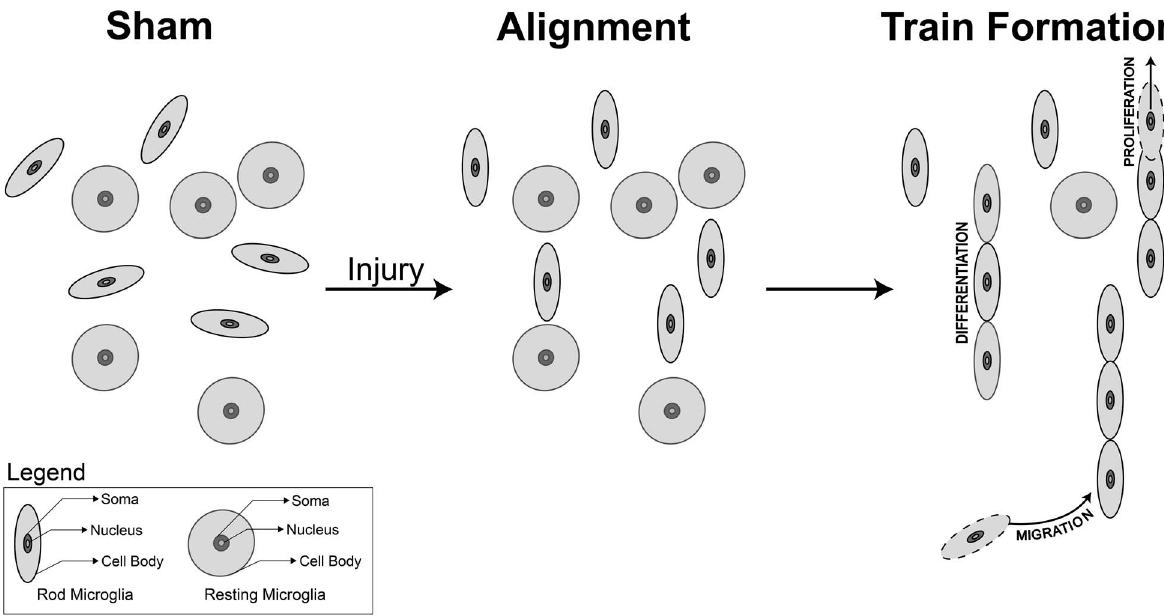
Figure 6. Schematic representation of rod microglia alignment and polarization post-injury. In the sham animals, rod-like microglia are sporadically found throughout all regions of the brain, these cells had sausage-like soma with no defined alignment or polarization in any plane. Post- injury, rod microglia aligned within the S1BF of the cortex, perpendicular to the dural surface. Rod microglia in the diffuse-injured rat brain show a ratio of 1.79 6 0.03 cell length:cell width at day 1 post-injury, which increases to 3.35 6 0.05 at day 7, compared to sham (1.17 6 0.02). The soma length:width differs only at day 7 post-injury compared to uninjured sham. Once alignment has occurred, rod microglia form ‘trains’, hypothesized through migration, proliferation and /or differentiation of existing resting microglia. It is clear that cell to cell signals control the migration of microglia, and presumably control their morphology. Microglial function follows morphology, however, the role and signaling cascade for rod microglia has yet to be identified.